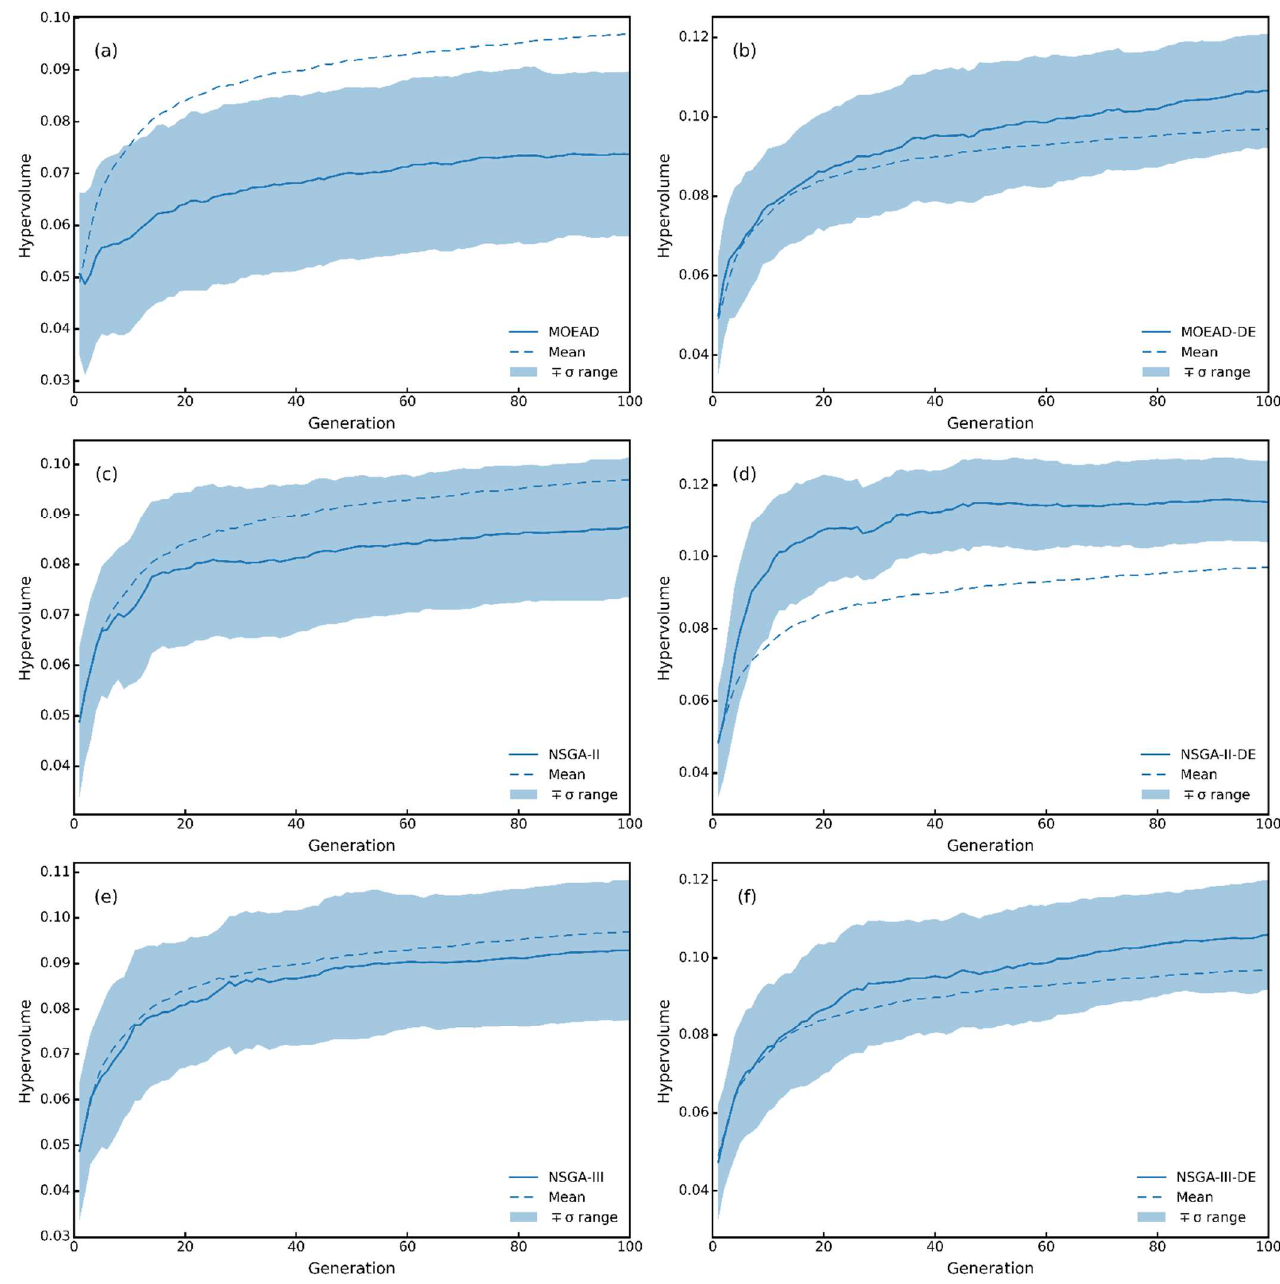
Figure 7. Hypervolume. ( a ) MOEAD; ( b ) MOEAD-DE; ( c ) NSGA-II; ( d ) NSGA-II-DE; ( e ) NSGA-III; ( f ) NSGA-III-DE.